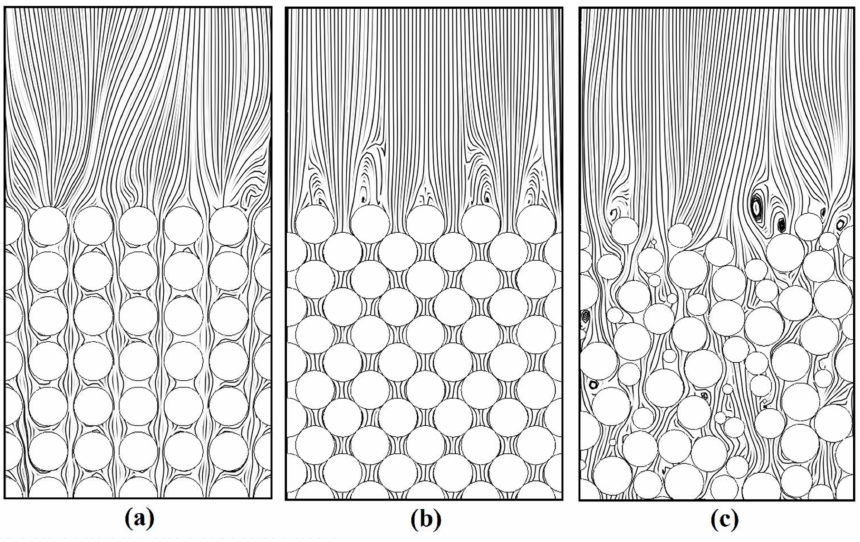
Figure 12. Flow streaklines from front plane cut plot ( a ) BCC; ( b ) FCC; ( c ) random.